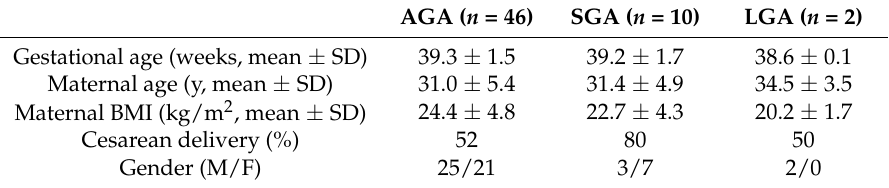
Table 1. Characteristics of the study population, according to fetal growth